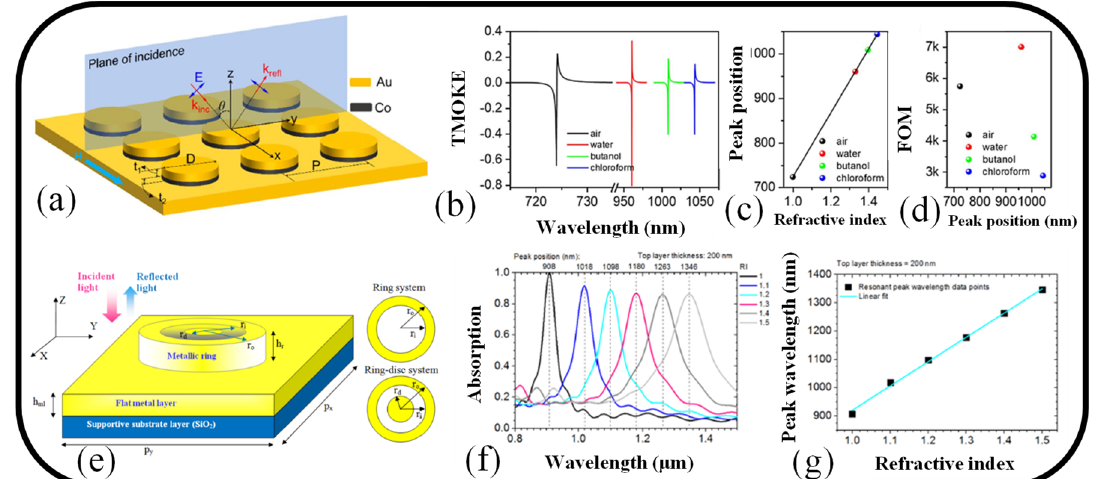
Figure 5. ( a ) Graphical interpretation of a magneto-plasmonic sensor established on a nanodisk array [82], ( b ) TMOKE spectrum for various ambient refractive indices [82], ( c ) Peak position of TMOKE curves as a function of RI [82], and ( d ) FOM as a function of wavelength [82]. ( e ) Graphical illustration of a plasmonic MS in 3D view. Reprinted with permission from Ref. [120], ( f ) Absorption spectrum. Reprinted with permission from Ref. [120], and ( g ) Plot of wavelength shift against ambient RI. Reprinted with permission from Ref. [120].